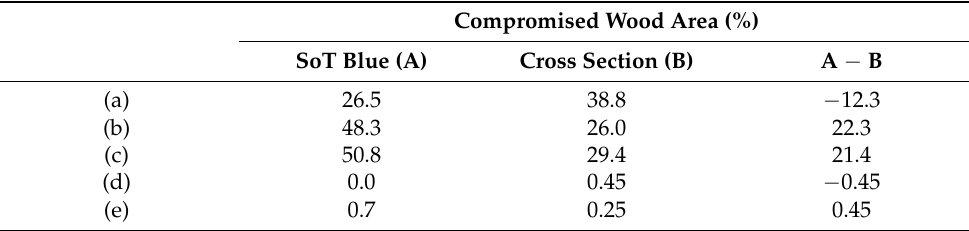
Table 2. Comparison of the sonic tomograms and the tree cross sections of the compromised wood